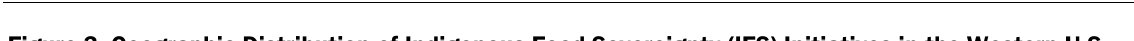
Figure 3. Geographic Distribution of Indigenous Food Sovereignty (IFS) Initiatives in the Western